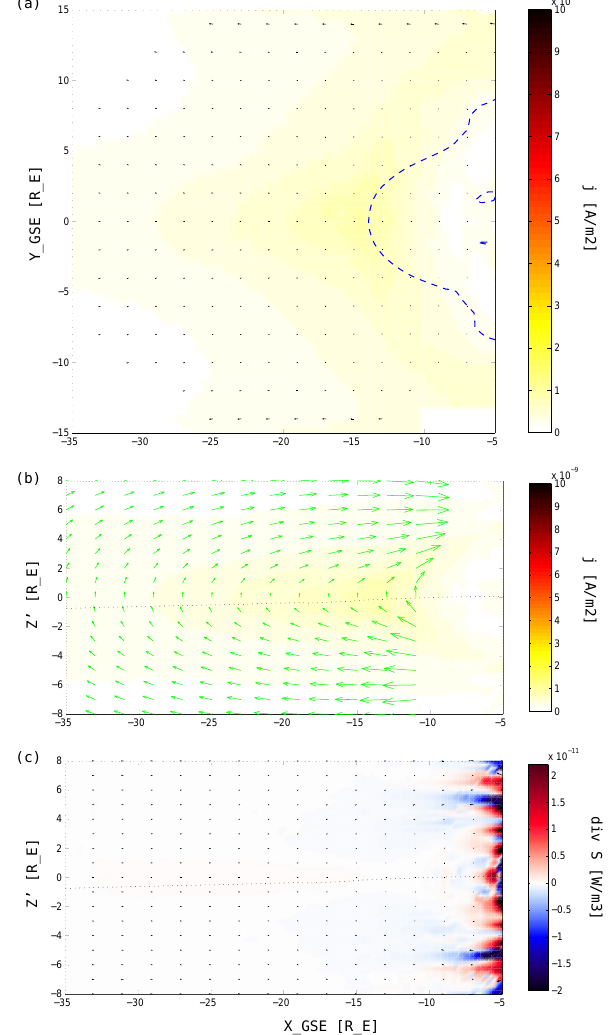
Fig. 4. The reconnection region in quiet time, i.e. before the re- connection starts. All panels depict the same instant, 2:00 in the synthetic IMF rotation run with small solar wind dynamic pressure and large IMF magnitude. The colour and vector scales are the same as in Figs. 5 and 9. (a) The current sheet seen from above, projected onto the xy plane in GSE coordinates. Coordinate units are Earth radiae. Colouring depicts current density, and the arrows are plasma flow velocity vectors. The blue dashed line is the flow reversal line. (b) The perpendicular plane (see Fig. 3), providing a side view of the same region. Colouring is again current density and the arrows are now magnetic field vectors on the plane. The magnetic field earthwards of x = − 10 is not drawn, since the arrows would be too long and clutter the image. ( c) The perpendicular plane again. Now the colouring is the divergence of the Poyntig vector, ∇· S , and the arrows are plasma flow velocity vectors (nearly invisible due to the smallness of velocities at this